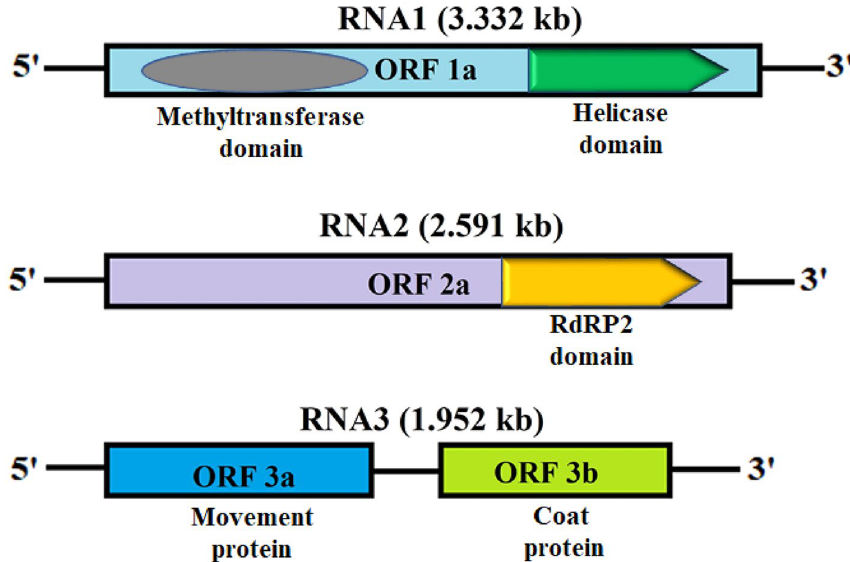
Figure 4. Diagrammatic illustration showing the characteristic domains and proteins of PNRSV RNA1, RNA2 and RNA3 encoded by their respective ORFs.